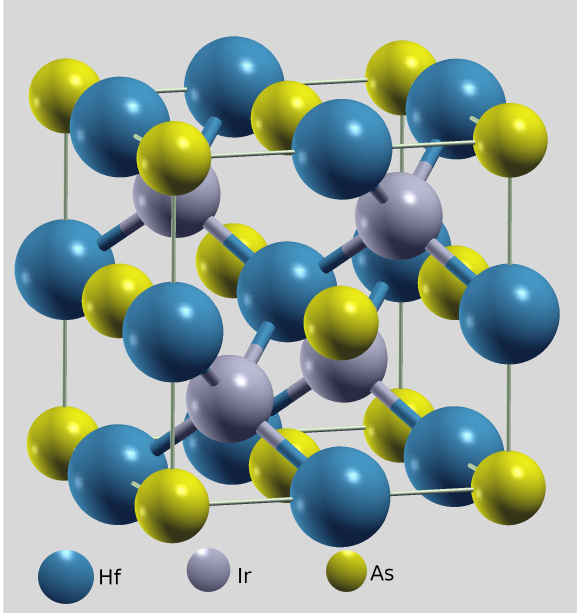
Figure 1. Crystal Structure of HfIrAs half-Heusler